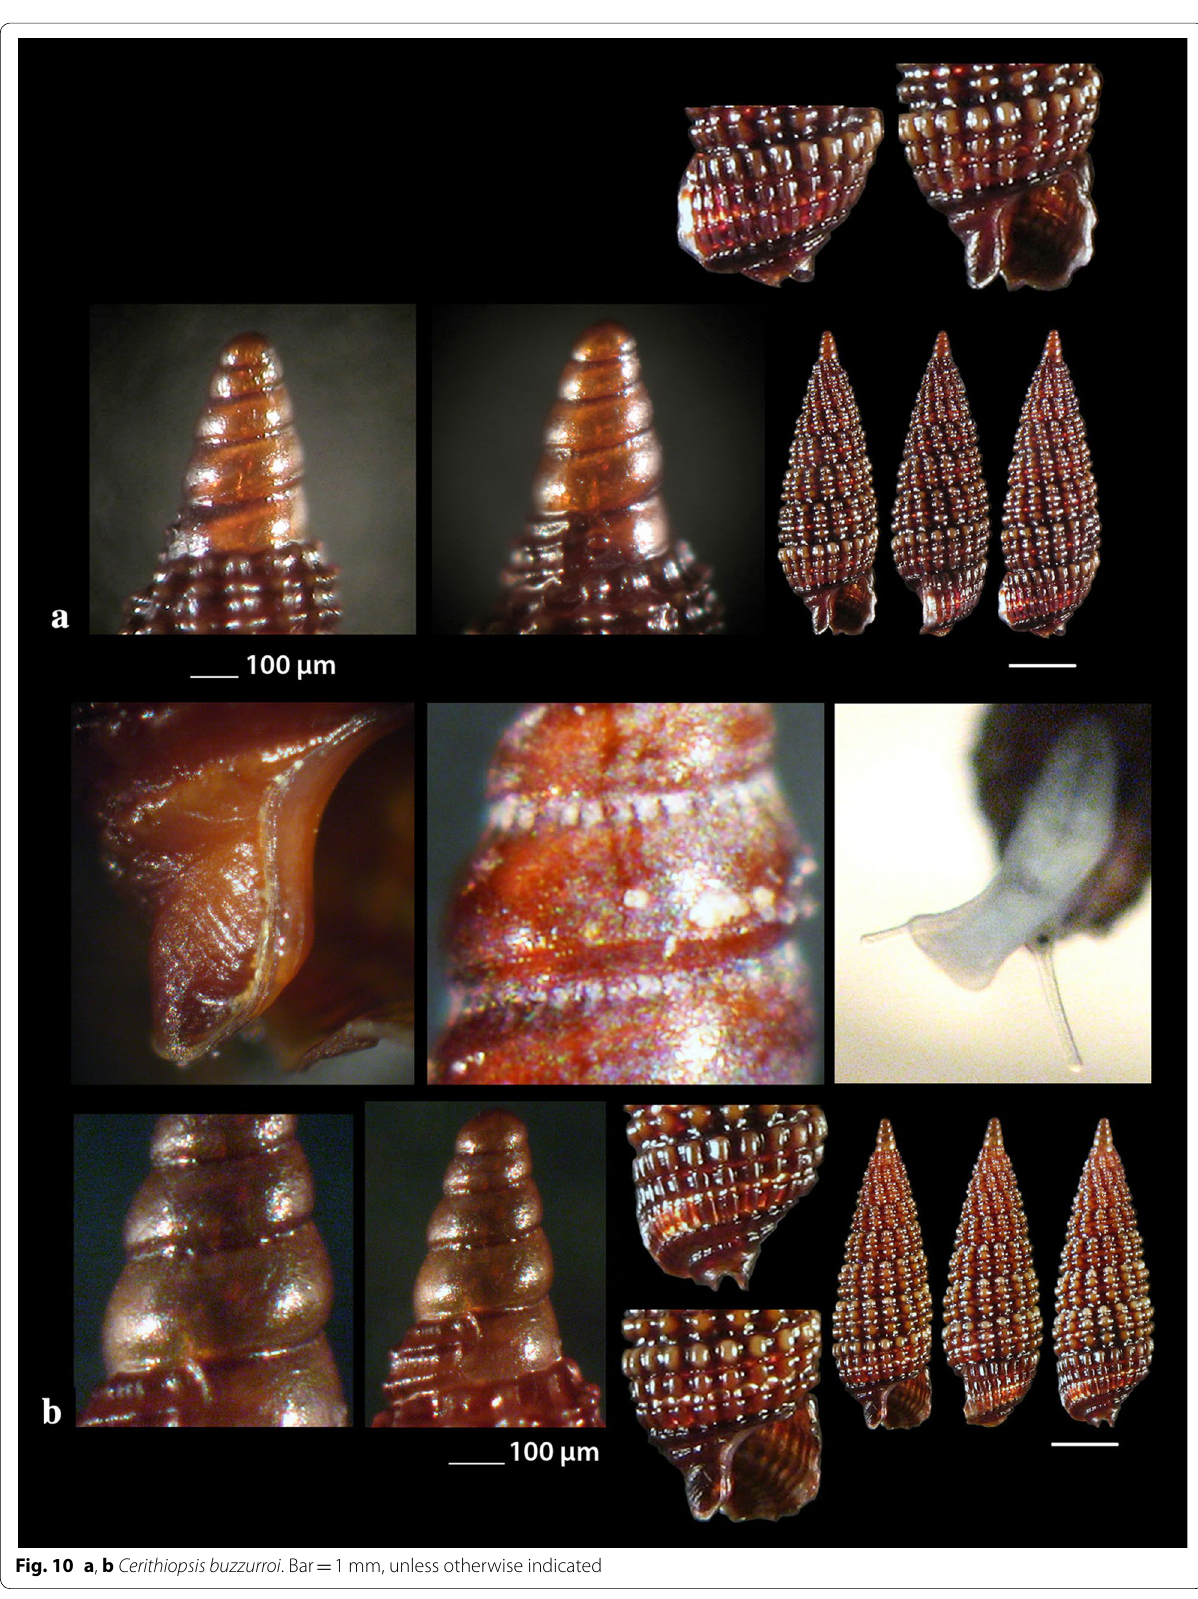
Fig. 10 a , b Cerithiopsis buzzurroi . Bar